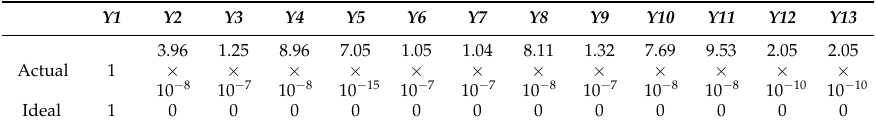
Table 5. The test results of a two symptoms ( X 3, X 5) to one fault ( Y 1) relationship.